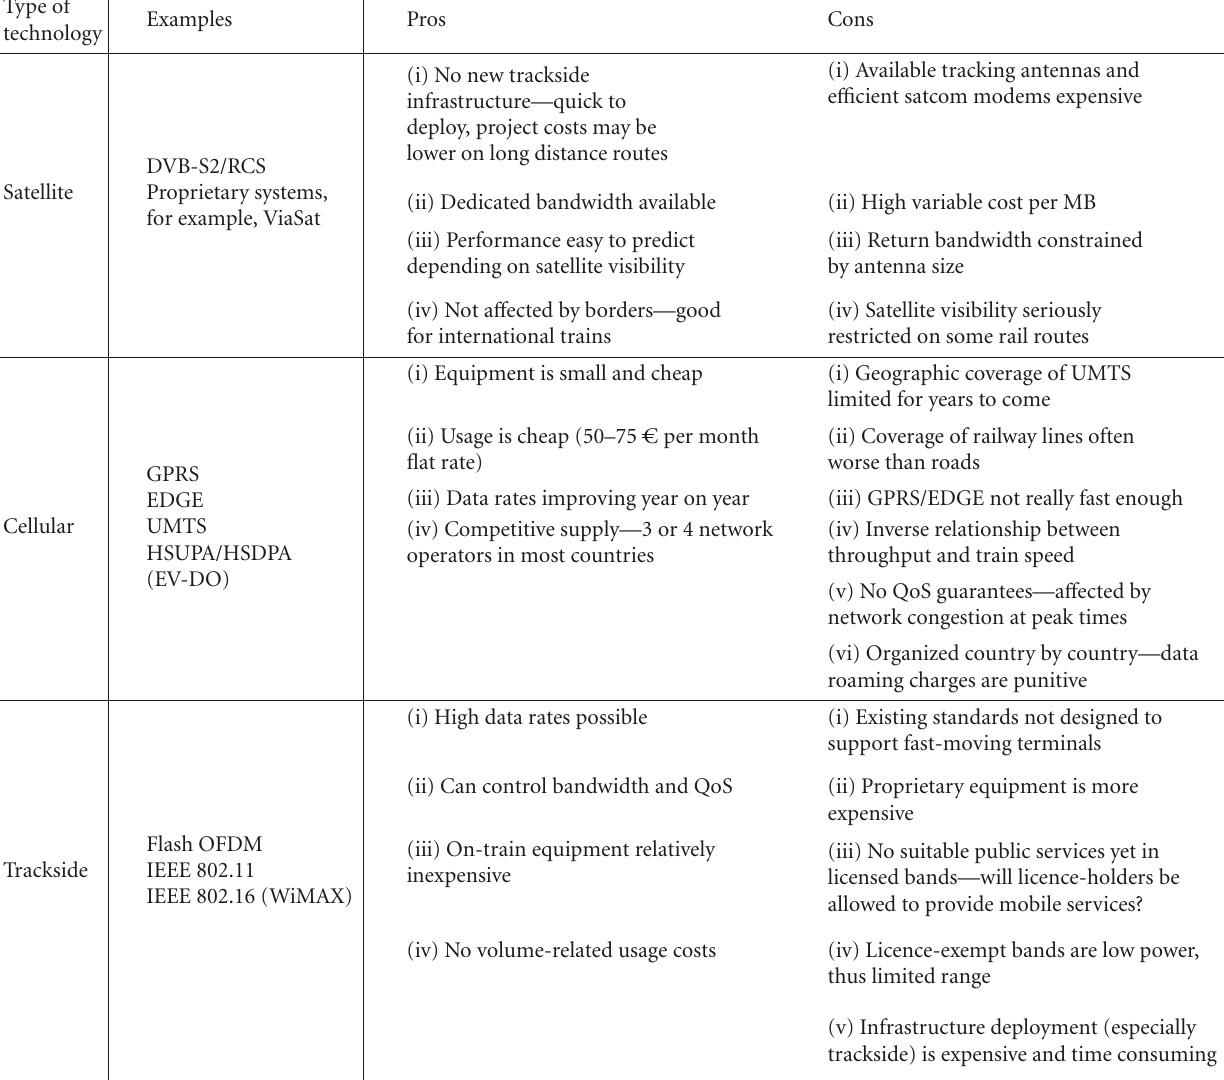
Table 1: Pros and cons of di ff erent solutions for providing broadband services on